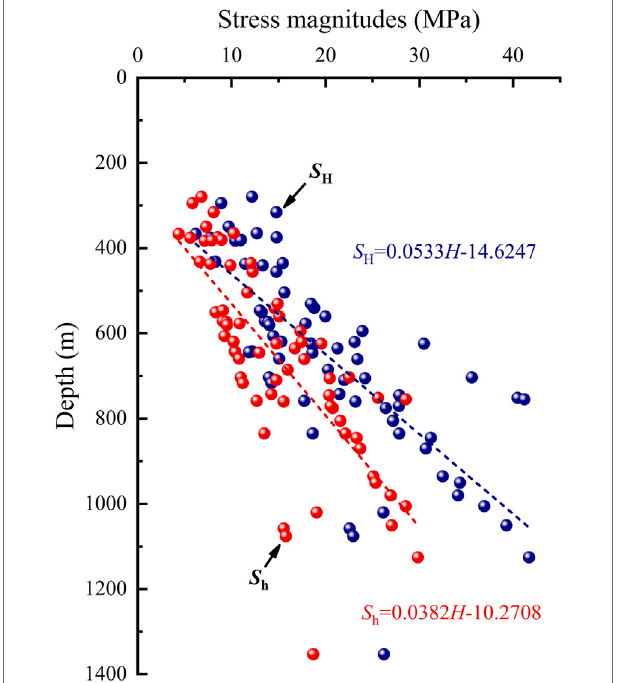
FIGURE 5 | Scatter diagram and fi tting curves of | in situ stress.